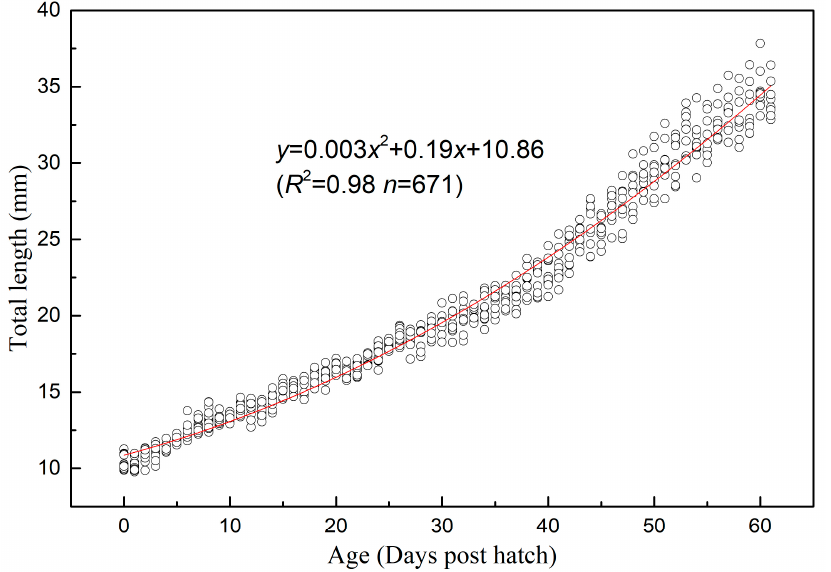
Figure 5. The correlation relationship between days post-hatch and total length of P. retrodorslis during larval and juvenile periods.